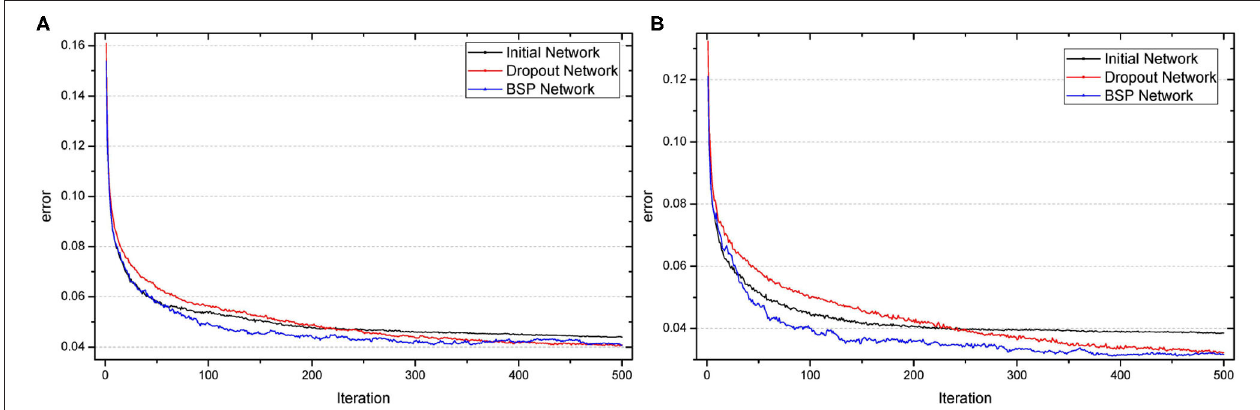
FIGURE 3 | Test error as a function of the number of iterations when the number of neurons in the hidden layer was 100 (A) or 500 (B) for 60,000 MNIST training samples.